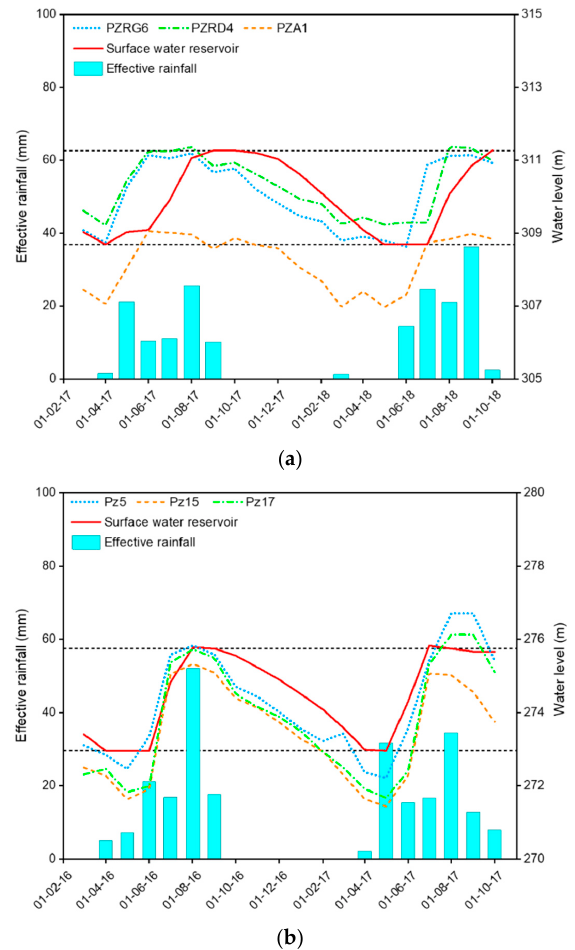
Figure 6. Times series data of effective rainfall and water levels in the Kierma ( a ) and Mogtédo ( b ) surface water reservoir (SWR) and the shallow aquifer. The two horizontal lines in the graphs correspond respectively to the maximum level and the bottom of the surface water reservoir.